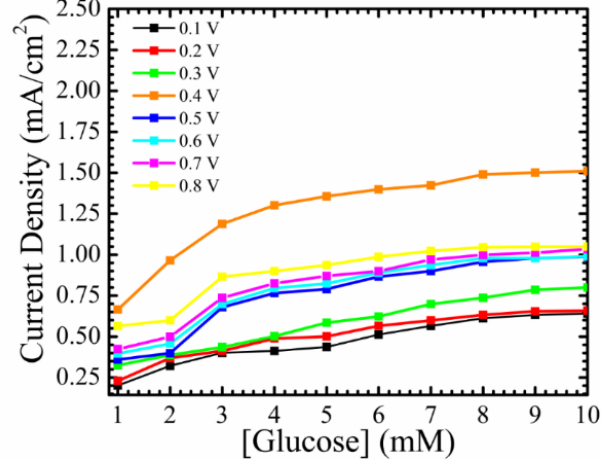
Figure 6. Current density of Si/SiO 2 /Au /GO x /Nafion (baseline) without the growth of ZnO NRs as a function of different glucose concentrations at different applied potentials.